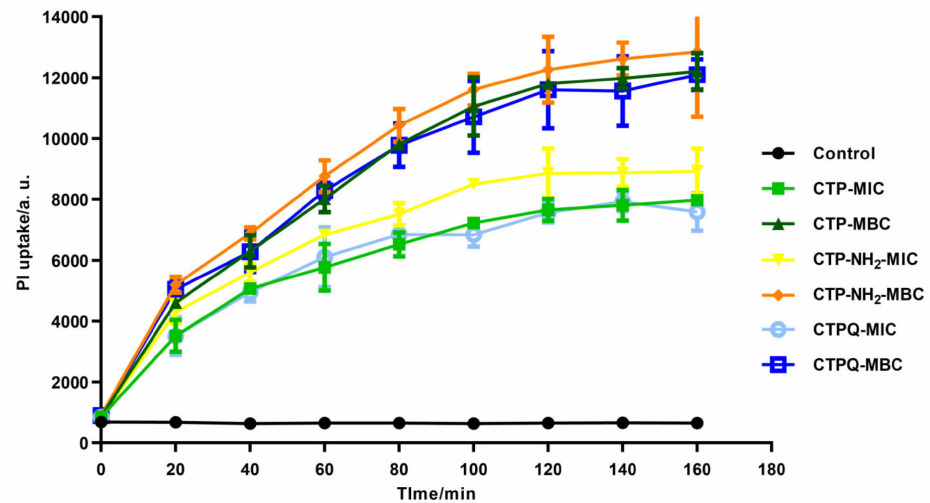
Figure 6. PI uptake of S. aureus ATCC 43300 treated with CTPs (CTP, CTP-NH2, and CTPQ) treatment at the MIC (32 µ g/mL) and the MBC (64 µ g/mL). Results are expressed in arbitrary units (a. u.).